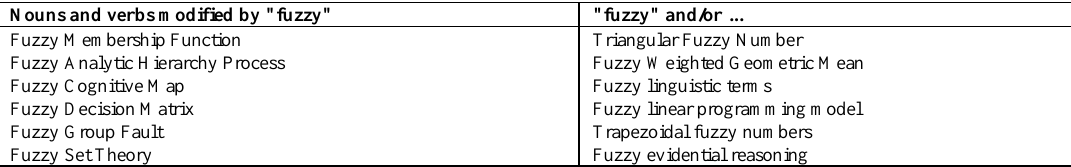
Table 3. Examples of applications of “Fuzzy logic” found within the considered pool of documents. Nouns and verbs modified by